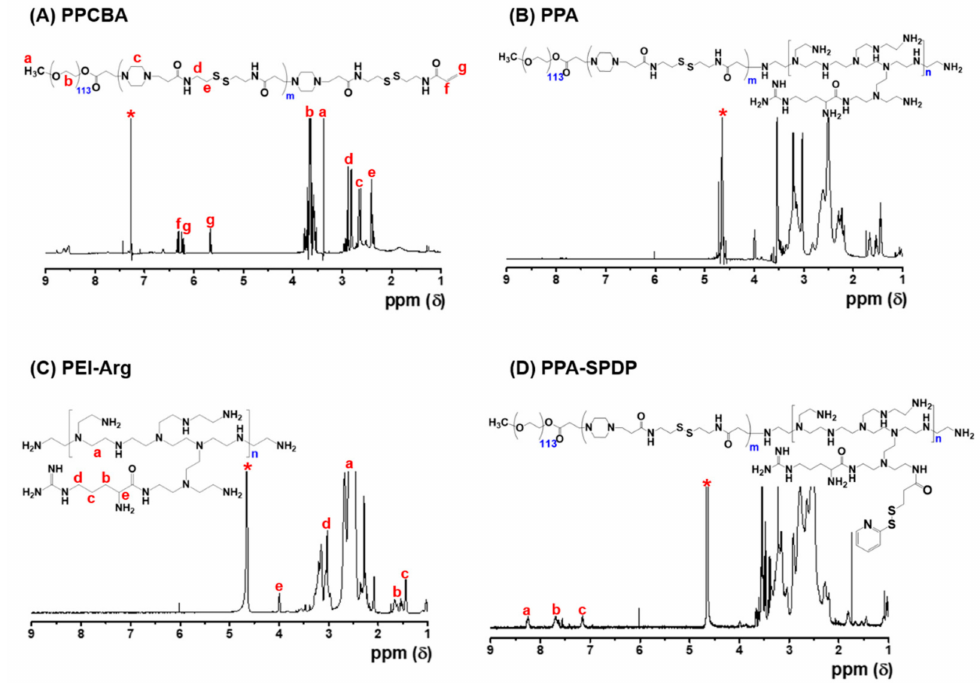
Figure 1. 1 H NMR spectra of ( A ) PPCBA copolymer, ( B ) PEI conjugate variants, ( C ) PPA copolymer, and ( D ) PPA-SPDP copolymer. Asterisks (*) in the spectra denotes residual solvents. The PPA copolymers were then reacted with SPDP to obtain PPA-SPDP copolymers for conjugation with Ad. 1 H NMR spectra of PPA-SPDP in Figure 1D show new characteristic